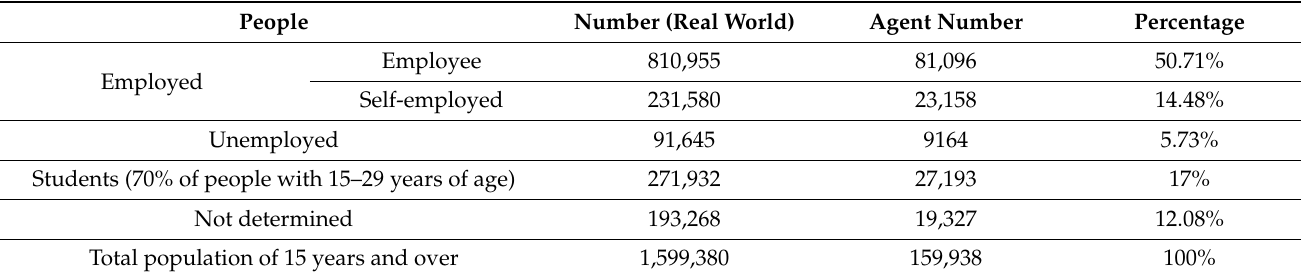
Table A3. Labor statistics of people 15 years of age and over in the year 2016